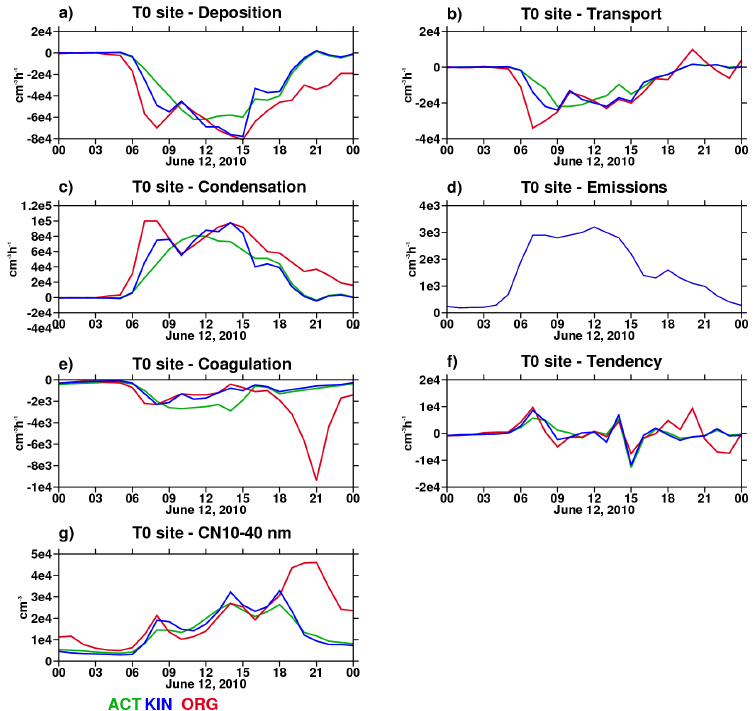
Figure 16. Budget diagnostic terms for 10–40nm particles at the T0 site on 12 June: (a) deposition; (b) transport; (c) condensation; (d) emis- sions; (e) coagulation; (f) total tendency; and (g) particle number